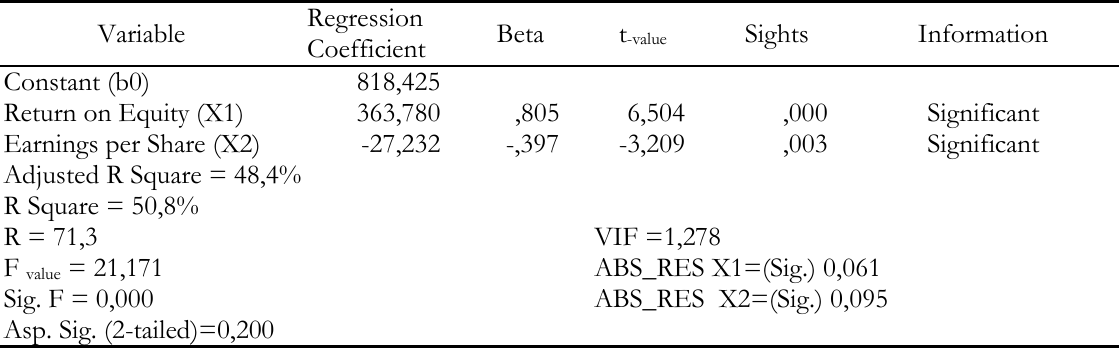
Table 1. Results of Regression Analysis Using SPSS Version